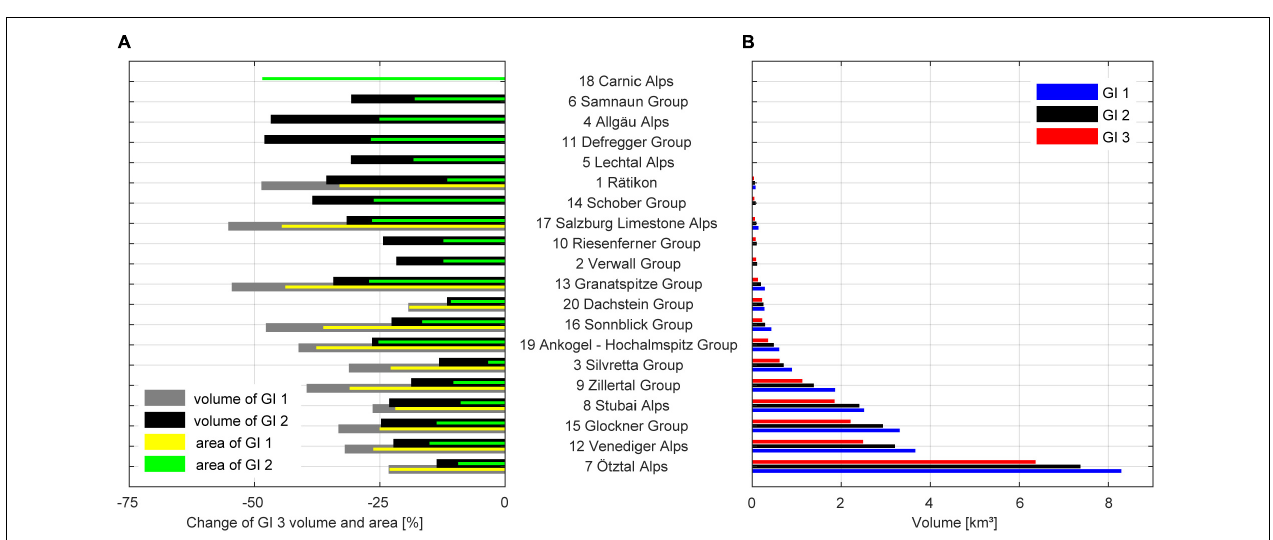
FIGURE 9 | (A) Relative changes in volume and area from GI 1 and GI 2 to the latest glacier inventory (GI 3) and (B) total volume of all glaciers in the respective mountain ranges. The five smallest volumes are less than 0.01 km 3 . Regions are ordered according to increasing total ice